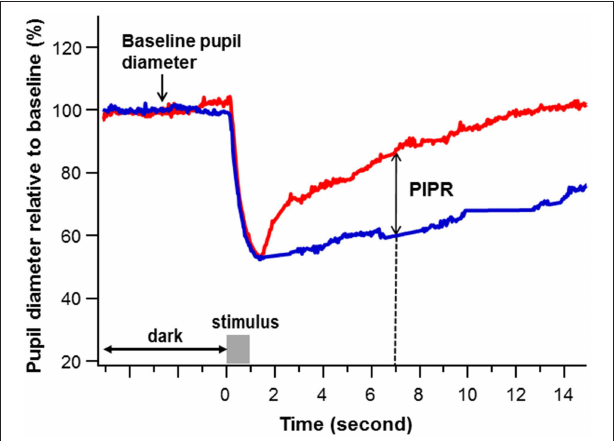
FIGURE 2 | Scatter plot of the average PIPR against PCA score, overlaid with the 95% confidence interval of the loess curve, showing a linear relationship between the average PIPR and PCA